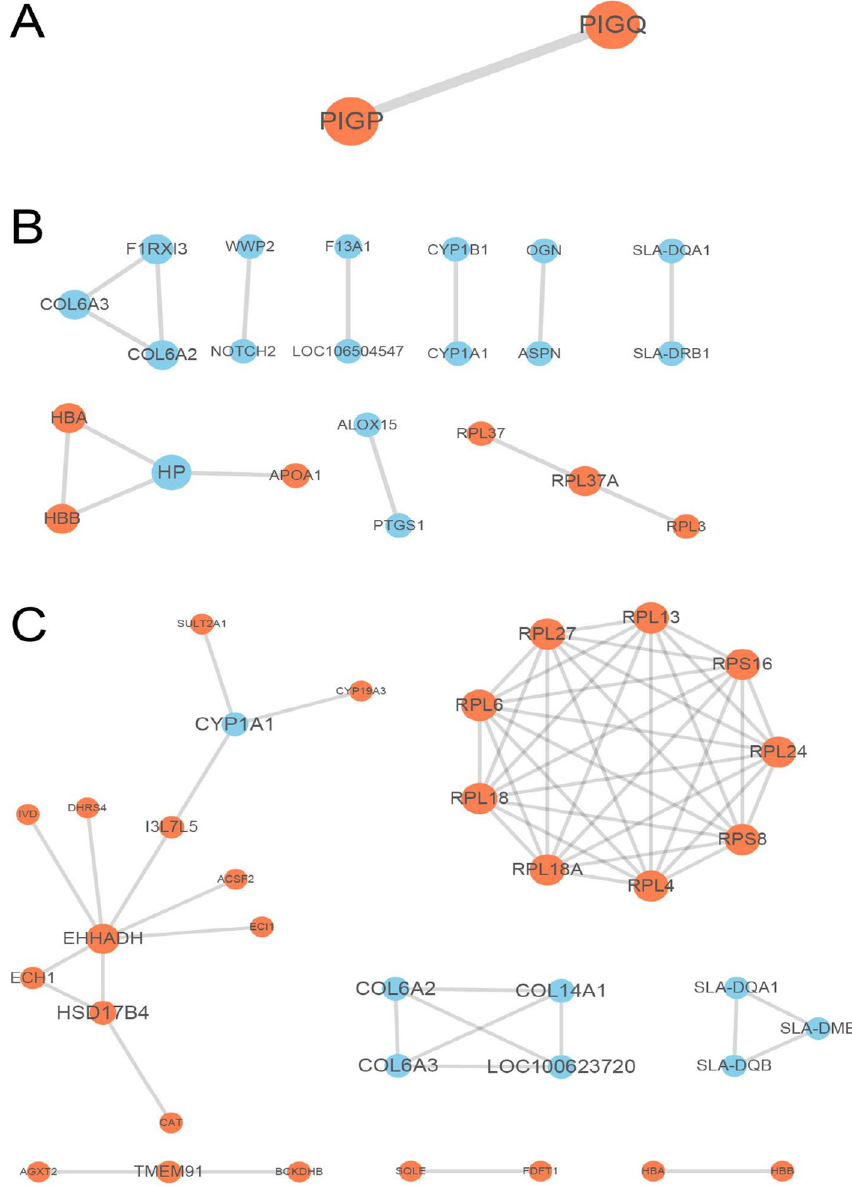
Figure 7. Protein–protein interaction (PPI) network generated for differentially abundant proteins (DAPs) using STRING. ( A ) S2 vs S1; ( B ) S3 vs S1; ( C ) S4 vs S1. We screened out the top 50 most closely interacting proteins and obtained all interactions exhibiting confidence scores ≥ 0.7 (high confidence). The circles in the figure indicate DAPs, and the red colour indicates significantly up-regulated DAPs, the blue colour indicates significantly down-regulated DAPs. The size of the circle represents the number of differential proteins and their interacting proteins. S1: control diet; S2: control diet supplemented with 1 μg/kg 1α,25(OH) 2 VD 3 ; S3: control diet supplemented with 2 μg/kg 1α,25(OH) 2 VD 3 ; S4: control diet supplemented with 4 μg/kg 1α,25(OH) 2 VD 3.